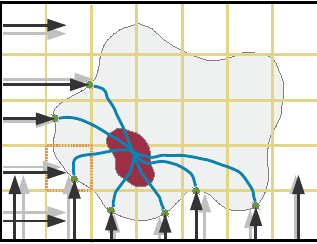
Figure 12. Computation of normal curves. Seeding points for the curves (green dots) are placed at the intersections between axis aligned rays (black arrows) and the outer isosurface (only rays from two directions are shown for illustration). Only a single seed is al- lowed in each grid box of the yellow volume.